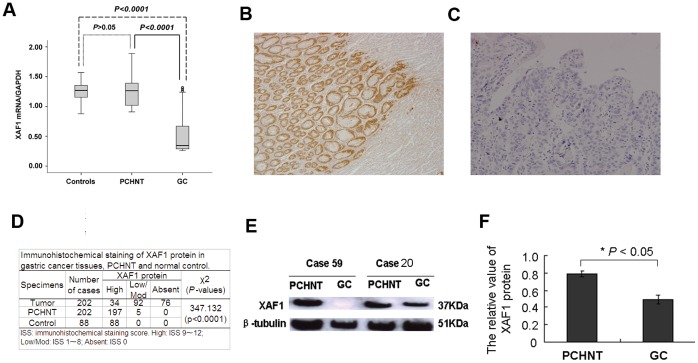

XAF1 gene expression was down-regulated in gastric cancer (GC) tissues.
A, XAF1 mRNA expression level in GC tissues, PCHNTs (para-cancerous histological normal tissue) and non-cancer controls were determined by real-time RT-PCR and was normalized to GAPDH. B–F, XAF1 protein expression was down-regulated in gastric cancer tissues. B, a representative positive, high expression of XAF1 protein in a PCHNT tissues; C, Absent of XAF1 expression in a poorly differentiated GC; original magnification ×200. D, a summary of XAF1 immunohistochemical staining results in 202 gastric cancers. E, Representative western blot analysis of XAF1 expression in gastric cancer and corresponding PCHNT specimens with different XAF1 methylation levels. PCHNT tissues in Case 59 (XAF1 methylation score: 0); GC tissues in Case 59 (methylated XAF1 score: 4); PCHNT tissues in Case 20 (methylated score: 0); GC tissues in Case 20 (methylated XAF1 score: 1). Beta-tubulin was used as internal control. F, Summary of the western blotting results from 20 GCs and corresponding PCHNTs presented as relative bands density normalized to the beta-tubulin of the same samples.